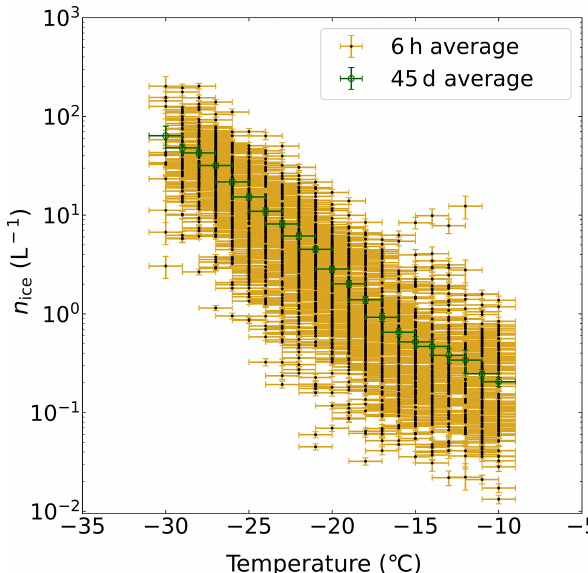
Figure 12. PINE-c INP concentration ( N ice ) measured as function of the representative gas temperature during the ExINP-SGP cam- paign at the ARM-SGP site in Oklahoma. PINE-c measured contin- uously for 45d from 1 October to 14 November 2019. Temperature- binned concentration data ( (cid:49)T = 1 ◦ C) are shown for 6h time av- eraged data (black markers) and 45d averaged data (green mark- ers). Note the temperature uncertainty of ± 1 ◦ C based on the homo- geneous freezing temperature calibration with ammonium sulfate aerosol particles. The N ice uncertainties represent relative standard errors of 6h averaged measurements at given temperatures. Statis- tical errors from low-counting signals are not considered here and will be the subject of further